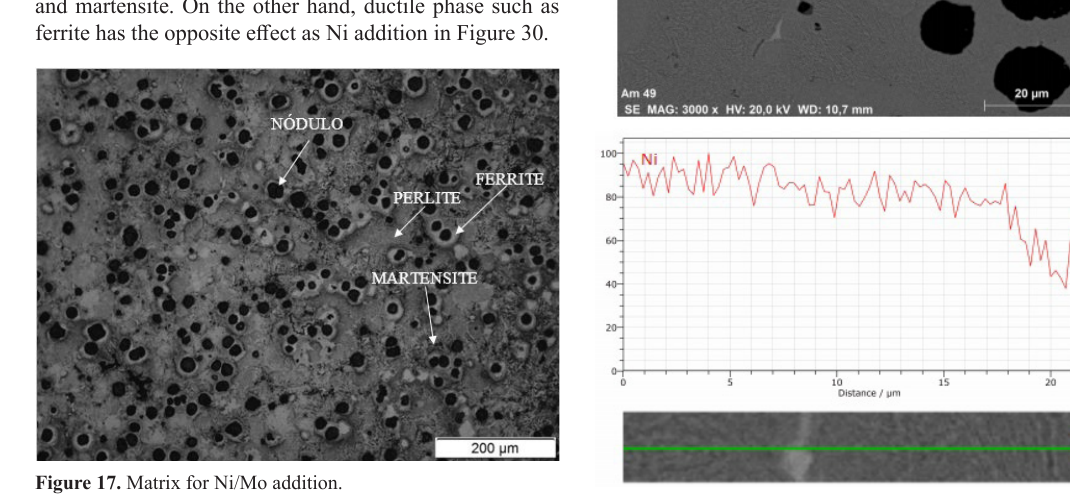
Figure 20. Ni EDS